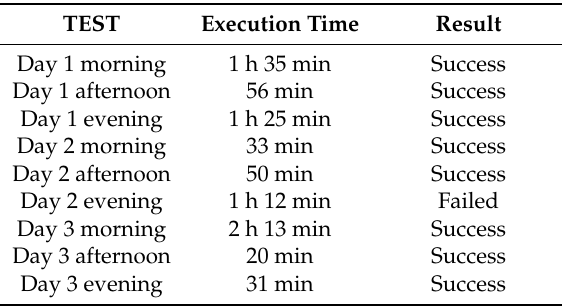
Table 1. Global results of the